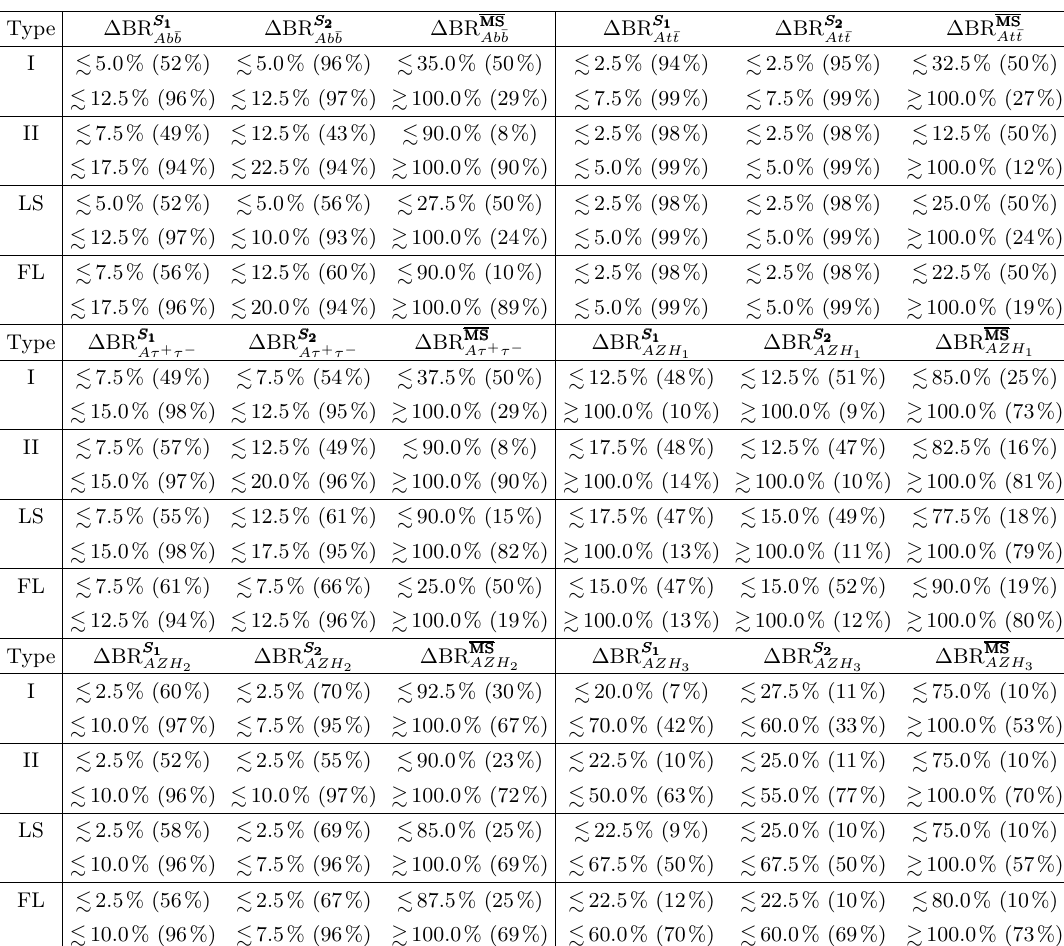
Table 26 . Relative size of the EW corrections to the BRs of the pseudoscalar A into b (cid:22) b , t (cid:22) t , (cid:28) + (cid:28) (cid:0) ,